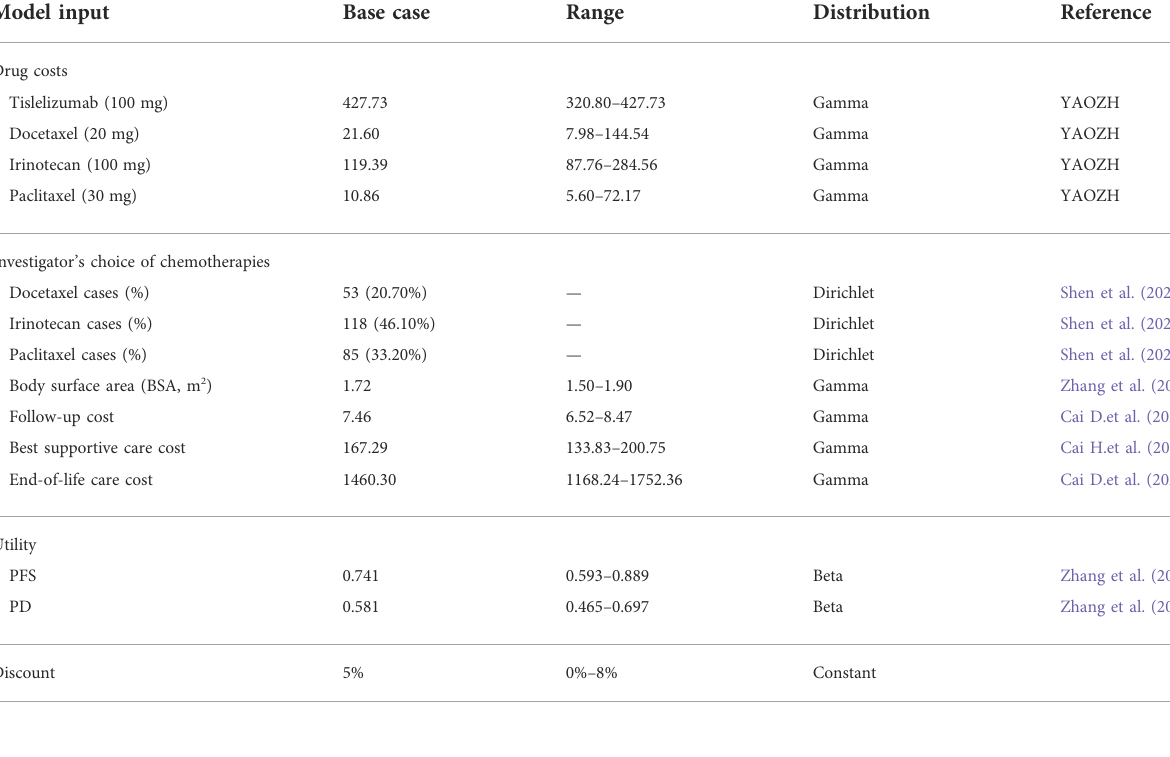
TABLE 2 Model input parameters.